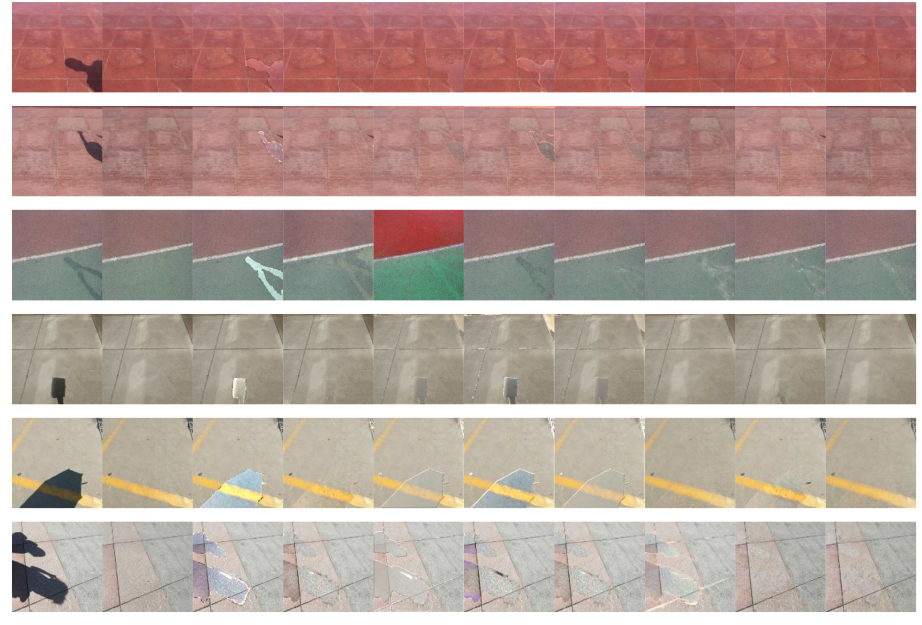
Figure 3. Schematic diagram of shadow removal in simple